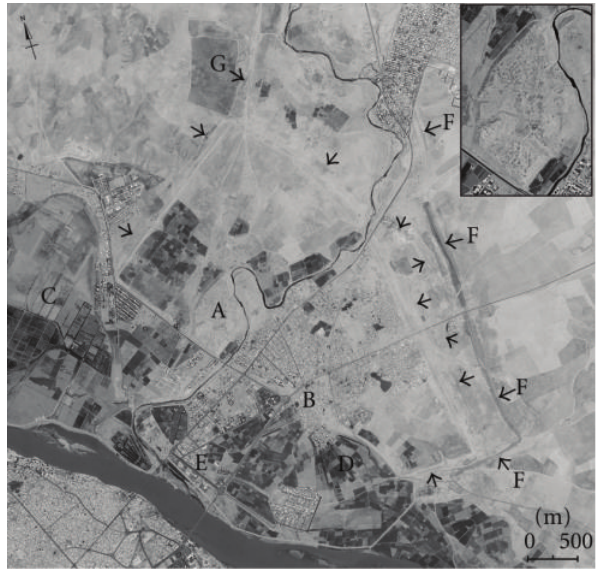
Figure 14: Nineveh in a Gambit KH-7 photo of June 9, 1967: (A) Kuyunjik; B, Nebi Yunus; (C-D) area with traces of paleo-river beds; (E) area at the confluence between the Tigris and the Khosr; big arrows show traces and remains of the ancient moats around the city walls, while small arrows point traces and remains of ancient canals (F-G). An enlargement of the image shows the mound of Kuyunjik.